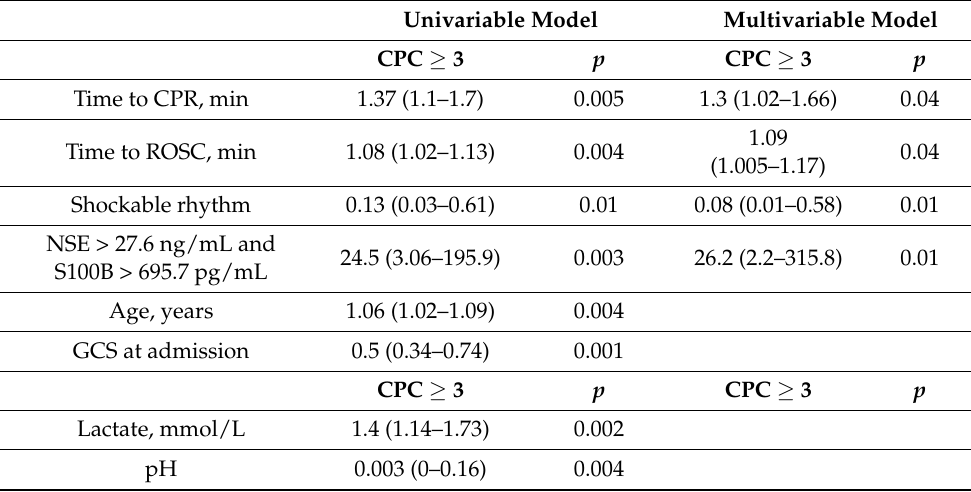
Table 2. Impact of clinical variables at admission on clinical outcome at discharge. The results of univariable and multivariable regression